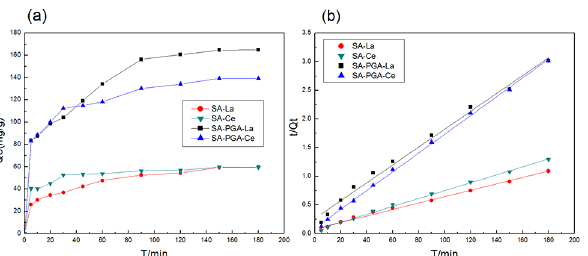
Fig 5. Adsorption kinetic curves (a) and pseudo-second-order plots (b) for the adsorption by gel particles.